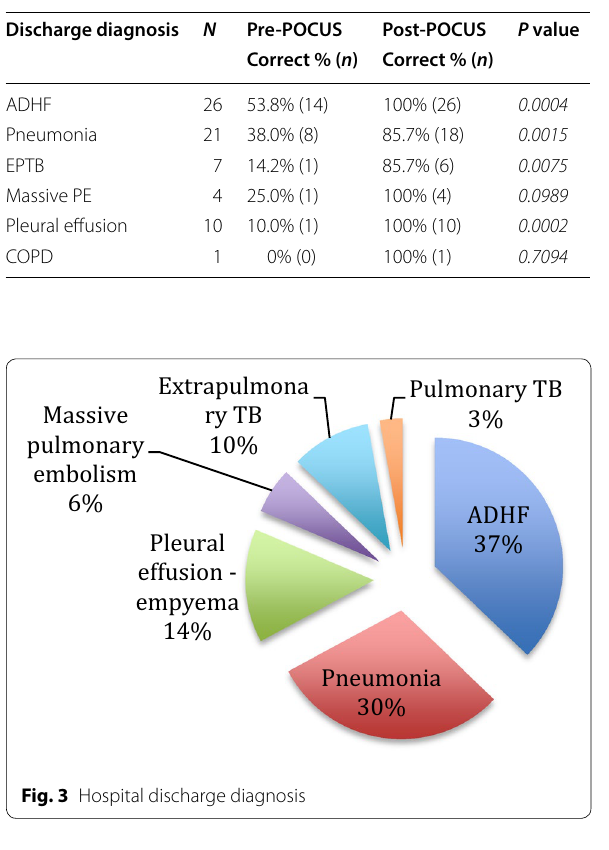
Table 4 Pre- and post-POCUS